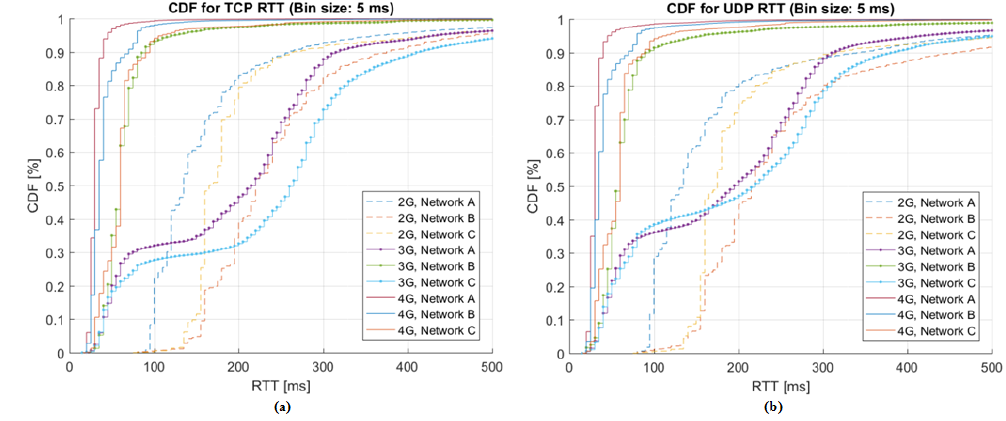
Figure 2. RTTs measured for ( a ) TCP and ( b ) UDP-based packets using three cellular networks in Denmark.